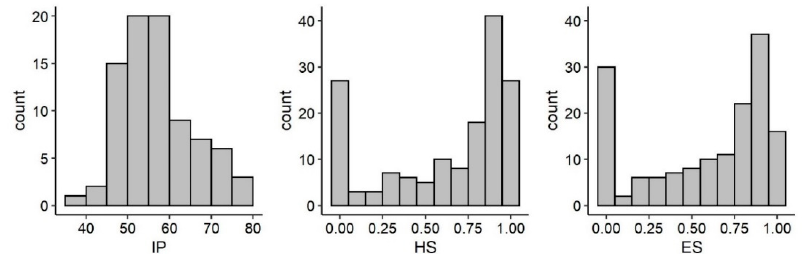
Figure 4. Frequency distribution of IP ( n = 83), HS ( n = 155), ES ( n = 155) in loggerhead turtle natural nests in Sicily.